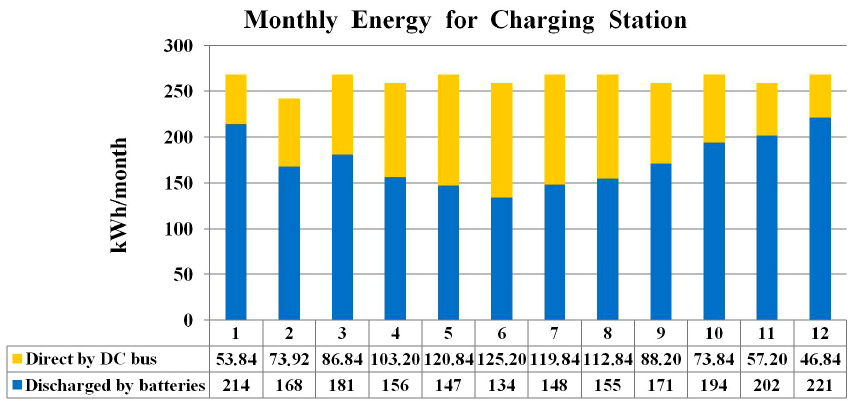
Figure 9. Monthly energy used by the EV charging station.